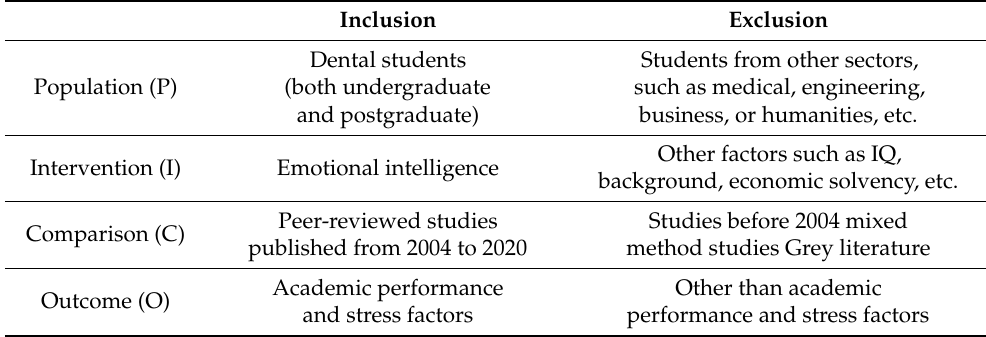
Table 4. Inclusion and exclusion